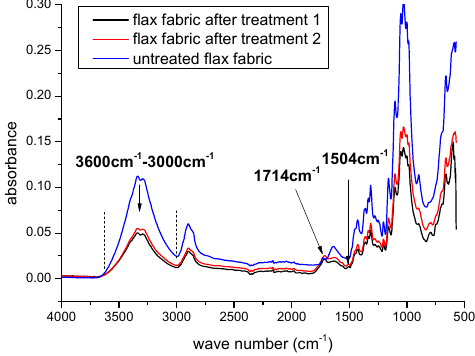
Figure 3. Infrared spectrum of FA treated and untreated flax fabrics.